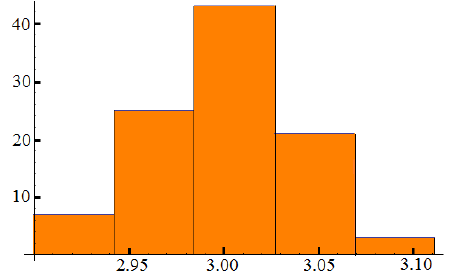
Figure 3. Frequency histogram for (cid:98) b n